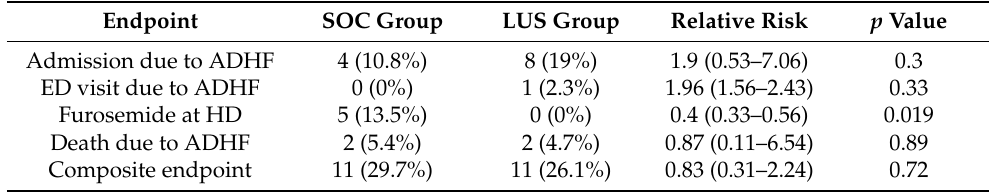
Table 3. Study outcome evaluation.